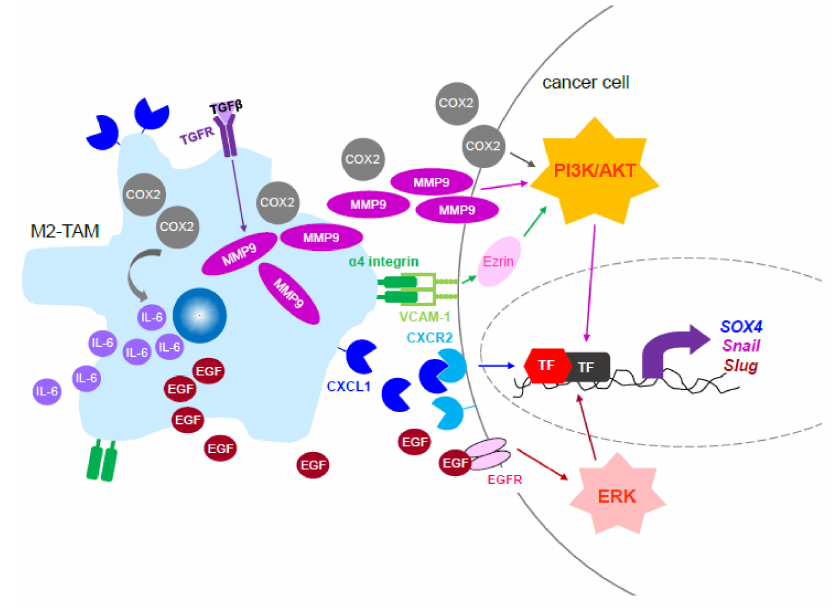
Figure 2. Signaling and the secreted factors of M2-TAM to promote cancer invasion and metastasis. The signaling molecules of M2-TAMs that modulate cancer cell migration, invasion, and metastasis through activation of phosphatidylinositol 3-kinase / human protein kinase B (PI3K / Akt) or ERK, either of which leads to upregulation of epithelial–mesenchymal transition (EMT) regulators, including Snail and Slug. Abbreviation, IL-6: interleukin-6; EGF: epithelial growth factor; EGFR: EGF receptor; MMP9: matrix metalloproteinase 9; VCAM-1: vascular cell adhesion protein-1; TF: transcription